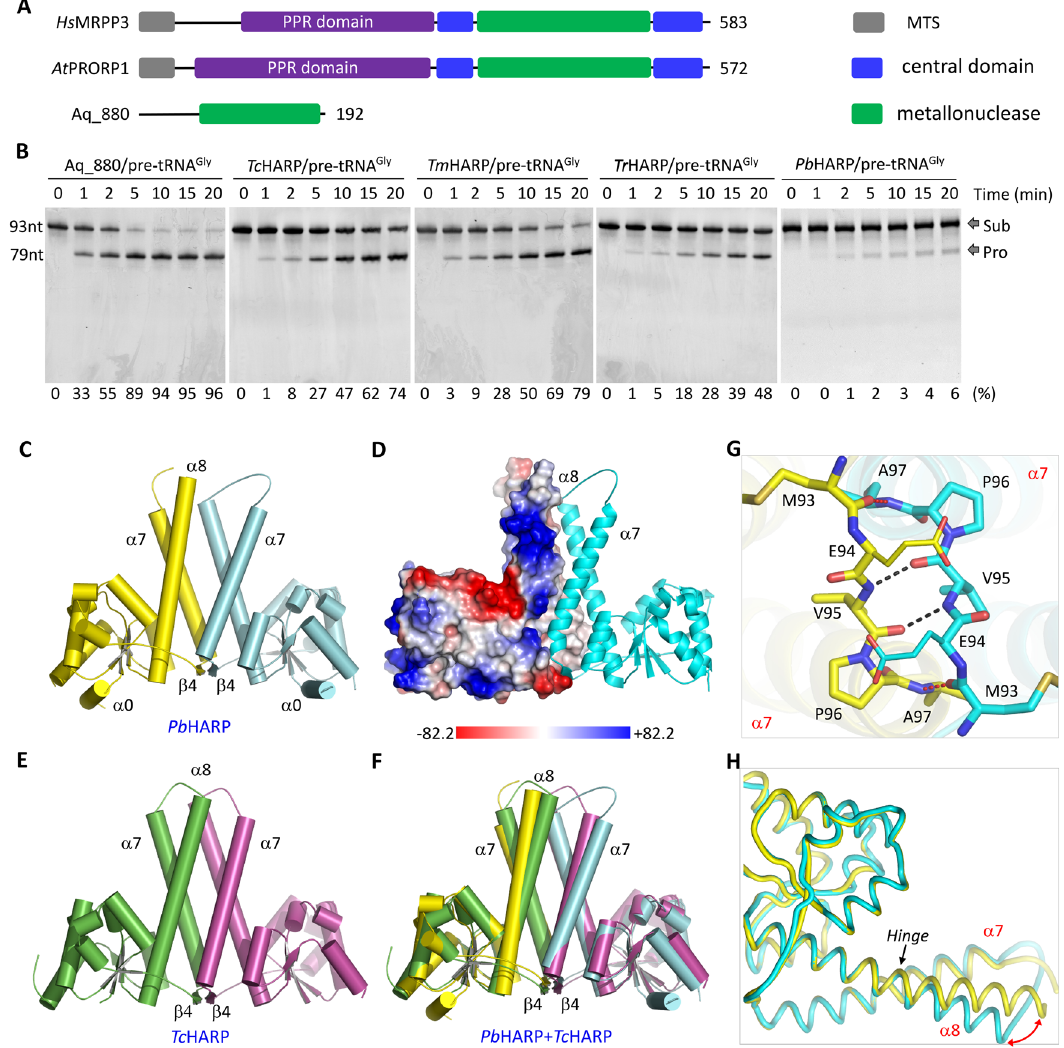
Fig. 1 pre-tRNA 5 ’ -end processing and folding of HARPs. A Domain architectures of PRORPs. B In vitro pre-tRNA Gly cleavage assays catalyzed by different HARPs. The substrate cleavage percentage (%) is shown at the bottom of the gels. Experiments were repeated independently twice with similar results. Source data are provided in Source Data fi le. C , D Cartoon and surface presentation showing the folding of Pb HARP AB dimer observed in the apo- form structure. E Cartoon presentation of the apo-form Tc HARP structure. F Structural superposition of Pb HARP and Tc HARP. The Pb HARP AB dimer is colored as in panel ( C ), the Tc HARP dimer is colored as in panel ( E ). G H-bond interactions involved in Pb HARP dimerization in the apo-form structure. H Structural superposition showing the conformational difference between the HB domains of Pb HARP A and B monomers. In panels ( G ), ( H ), the C-atoms are colored in yellow and cyan in the A and B monomers,